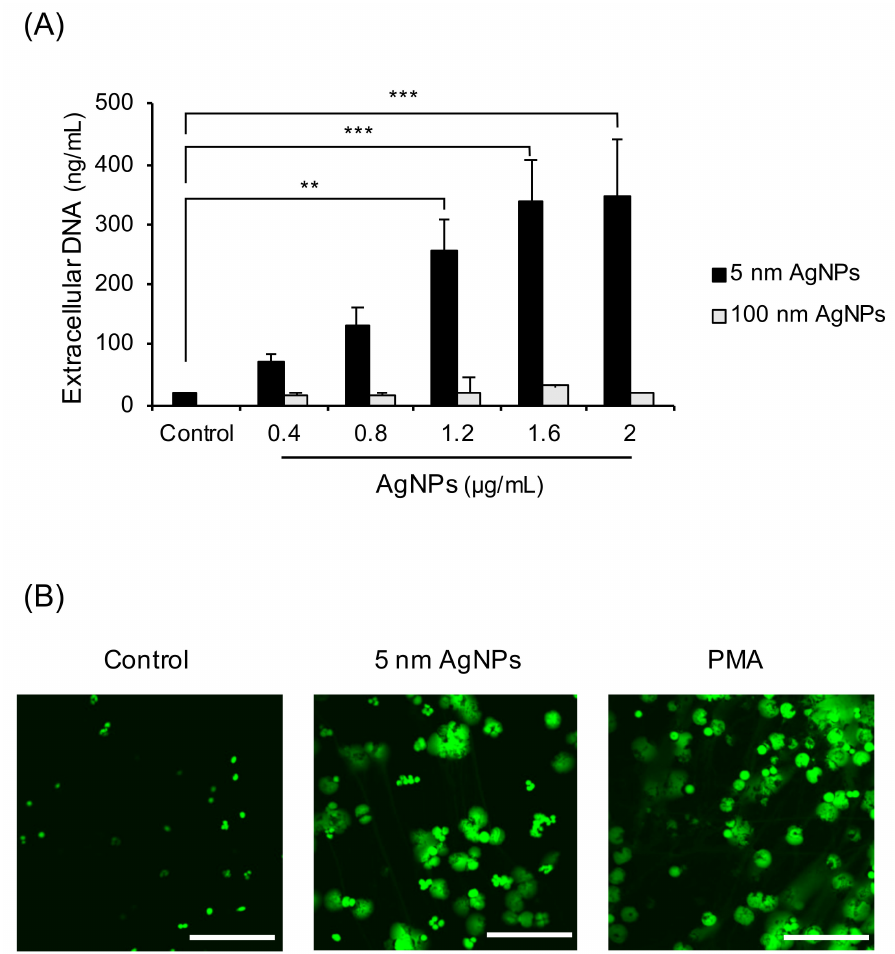
Figure 1. Induction of NET formation by 5 nm AgNPs. ( A ) Human neutrophils were treated with AgNPs for 4 h, and extracellular DNA was measured. ( B ) Neutrophils were treated with 1.6 µ g/mL of 5 nm AgNPs or 5 ng/mL PMA for 4 h, and the DNA was stained using SYTOX Green. Scale bar: 100 µ m. One-way ANOVA was used to determine the significance (** p < 0.01, *** p < 0.001). All experiments were performed in duplicate and repeated three times with different